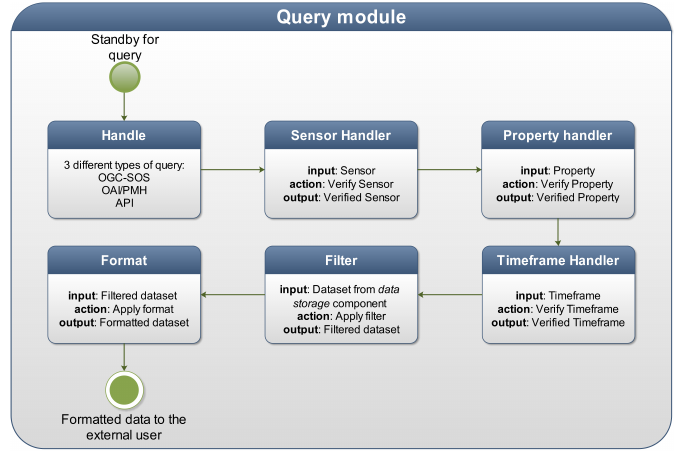
Figure 3. A typical data processing